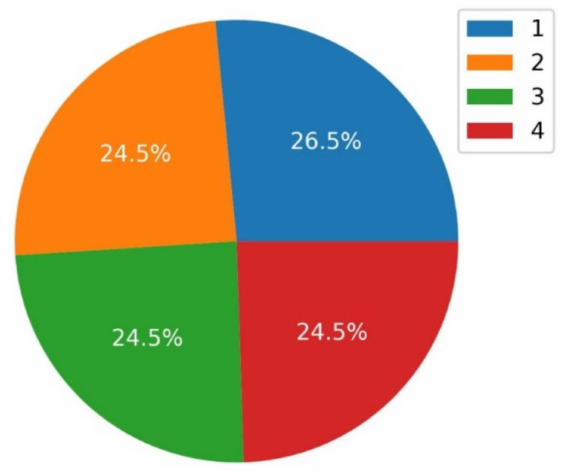
Figure 2. Elements in each class.